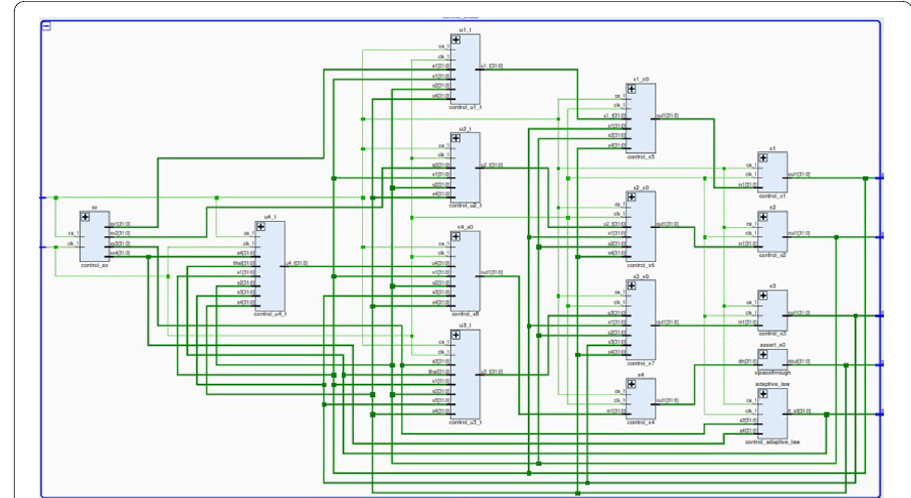
Figure 15 Xilinx RTL schematics of the ASMC.